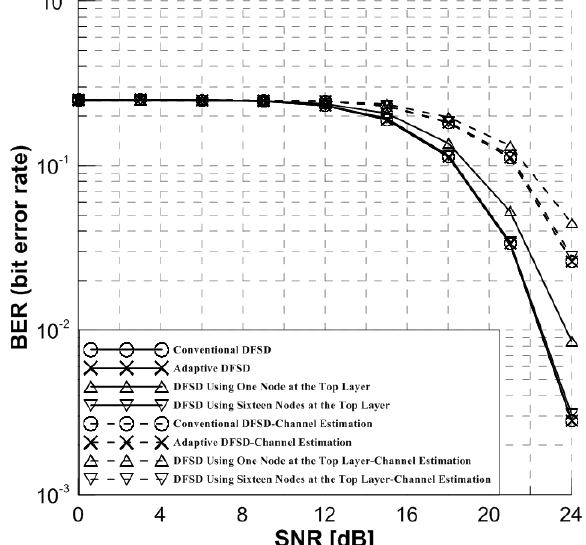
Figure 9. The error performance of the detection schemes with 64-QAM at the estimated